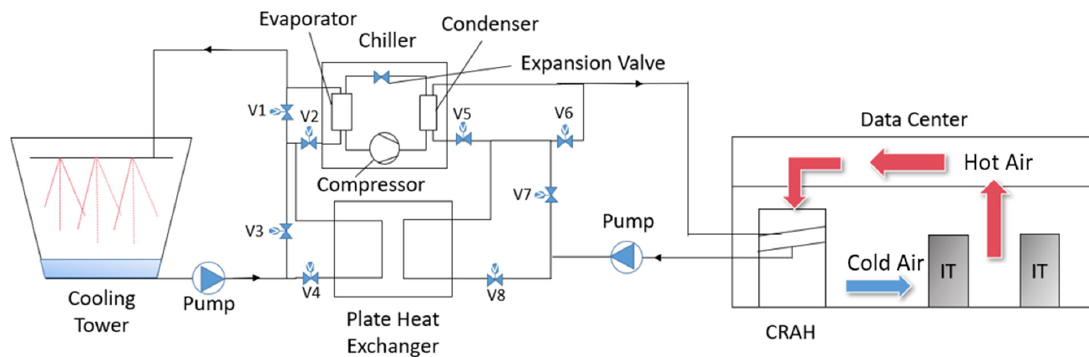
Figure 8. Plate heat exchangers in series with chillers.